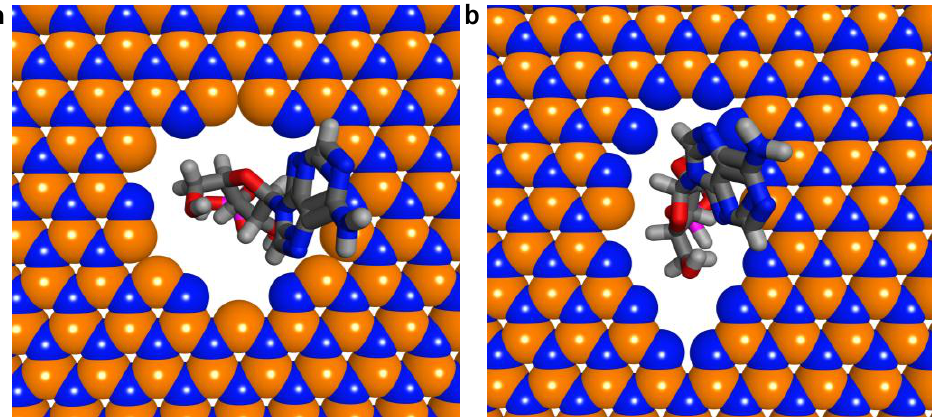
Figure 6. Hexagonal boron nitride (hBN) nanopores of different geometries and illustration of nucleotides passing through the nanopore: ( a ) circular nanopore; ( b ) elliptical nanopore.